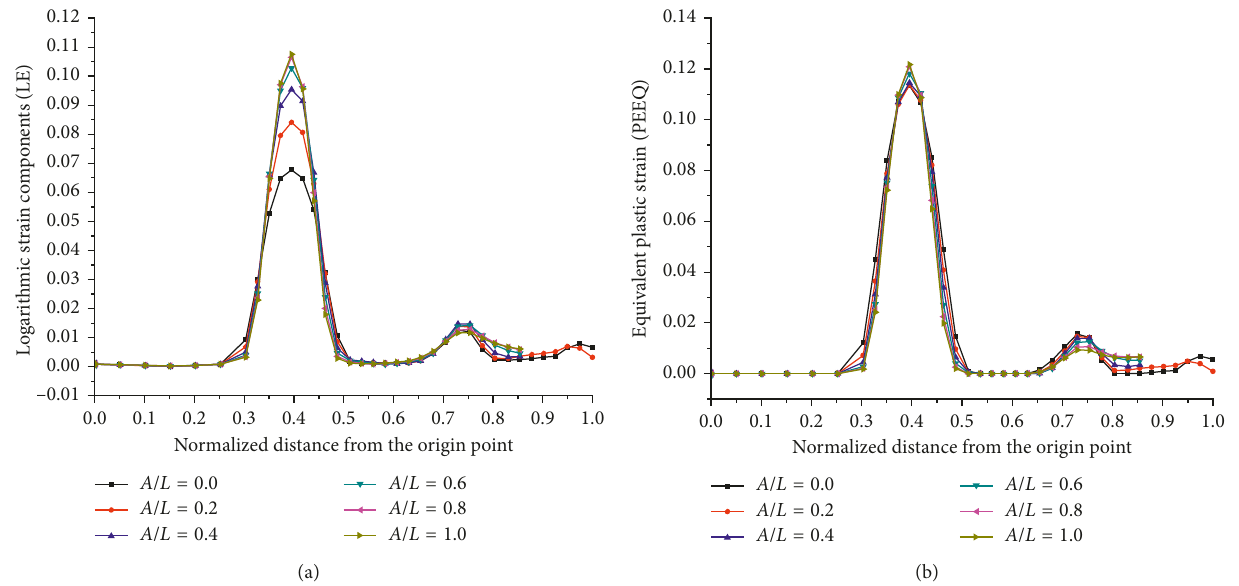
Figure 12: Strain distribution diagram of the wedge-shaped part of the joint. (a) Logarithmic strain components of the wedge-shaped part of the joint. (b) Equivalent plastic strain of the wedge-shaped part of the